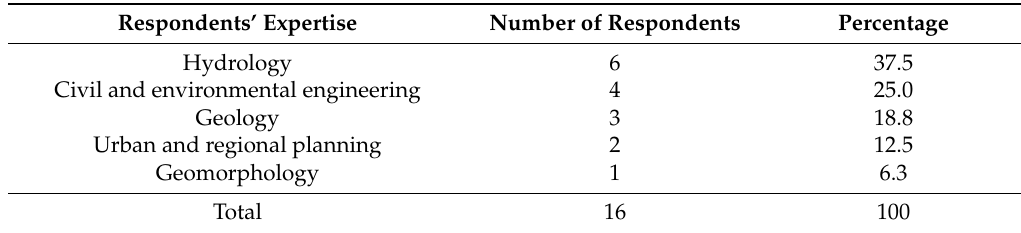
Table 1. Distribution of survey respondents by expertise.